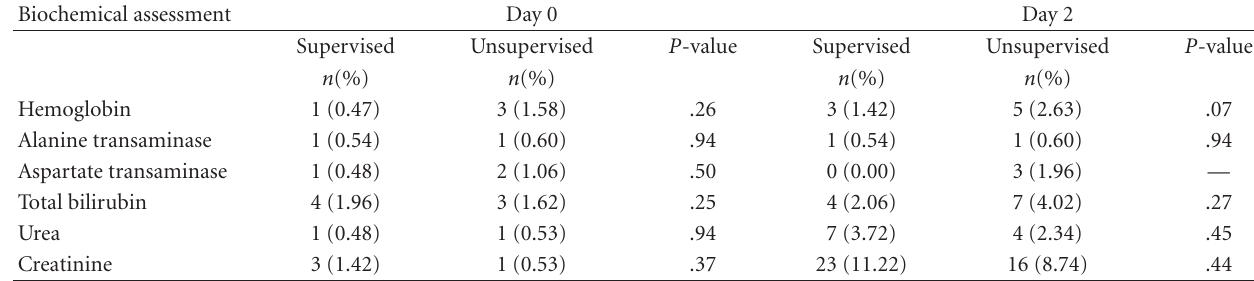
Table 4: Proportion of participants with high ( ≥ grade 3 CTCAE v3 classification) haematological and biochemical indices at Days 0 and 2. Biochemical assessment Day 0 Day 2 Supervised Unsupervised P -value Supervised Unsupervised P -value n (%) n (%) n (%) n (%) Hemoglobin 1